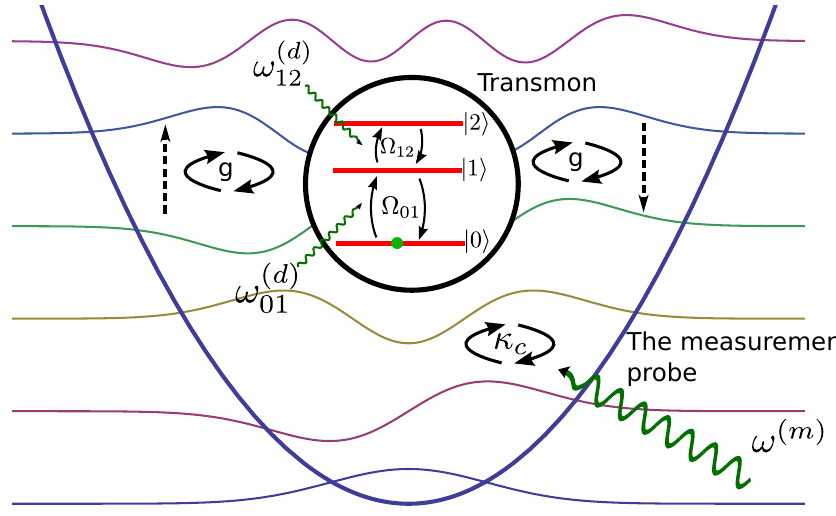
Figure 7. In a circuit QED architecture, the three-level system (for example a transmon) is dispersively coupled to the modes of a cavity, which is used as a read-out. In this configuration, one can perform full quantum tomography of the three-level